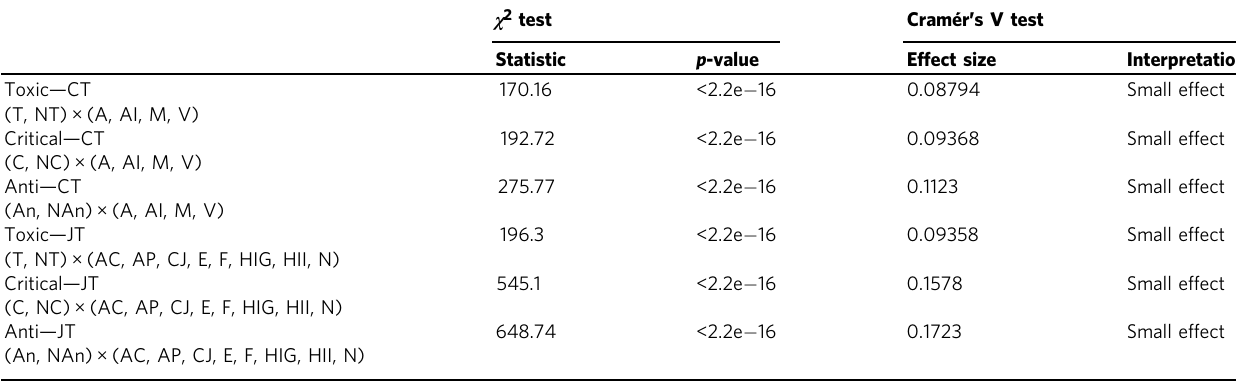
Table 4 Summary of the results of the χ 2 test and of the Cramér ’ s V test.